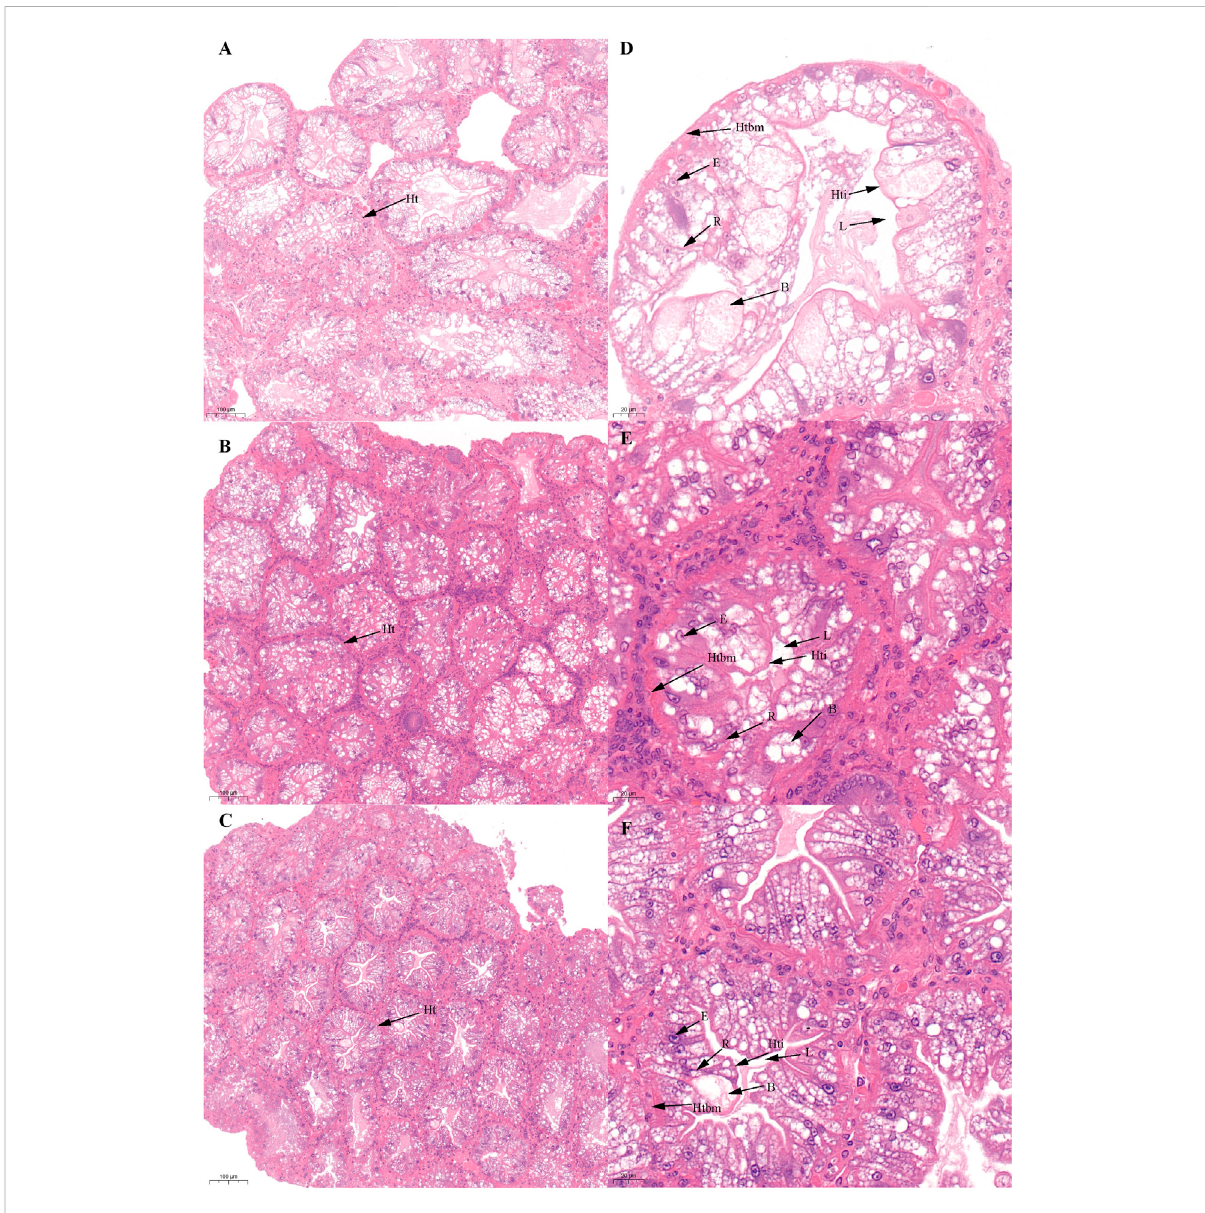
FIGURE 5 Histologicalcharacteristicsinthehepatopancreasof Scyllaparamamosain duringtheSVP. (A,D) :ovarianstage Ⅲ (S-Hep-3); (B,E) :ovarianstage Ⅳ (S-Hep-4); (C,F) : ovarian stage Ⅴ (S-Hep-5). Ht, Hepatic tubule; B, B-cell; R, R-cell; L, Lumen; Hti, Hepatic tubule intima; Htbm, Hepatic tubule basement